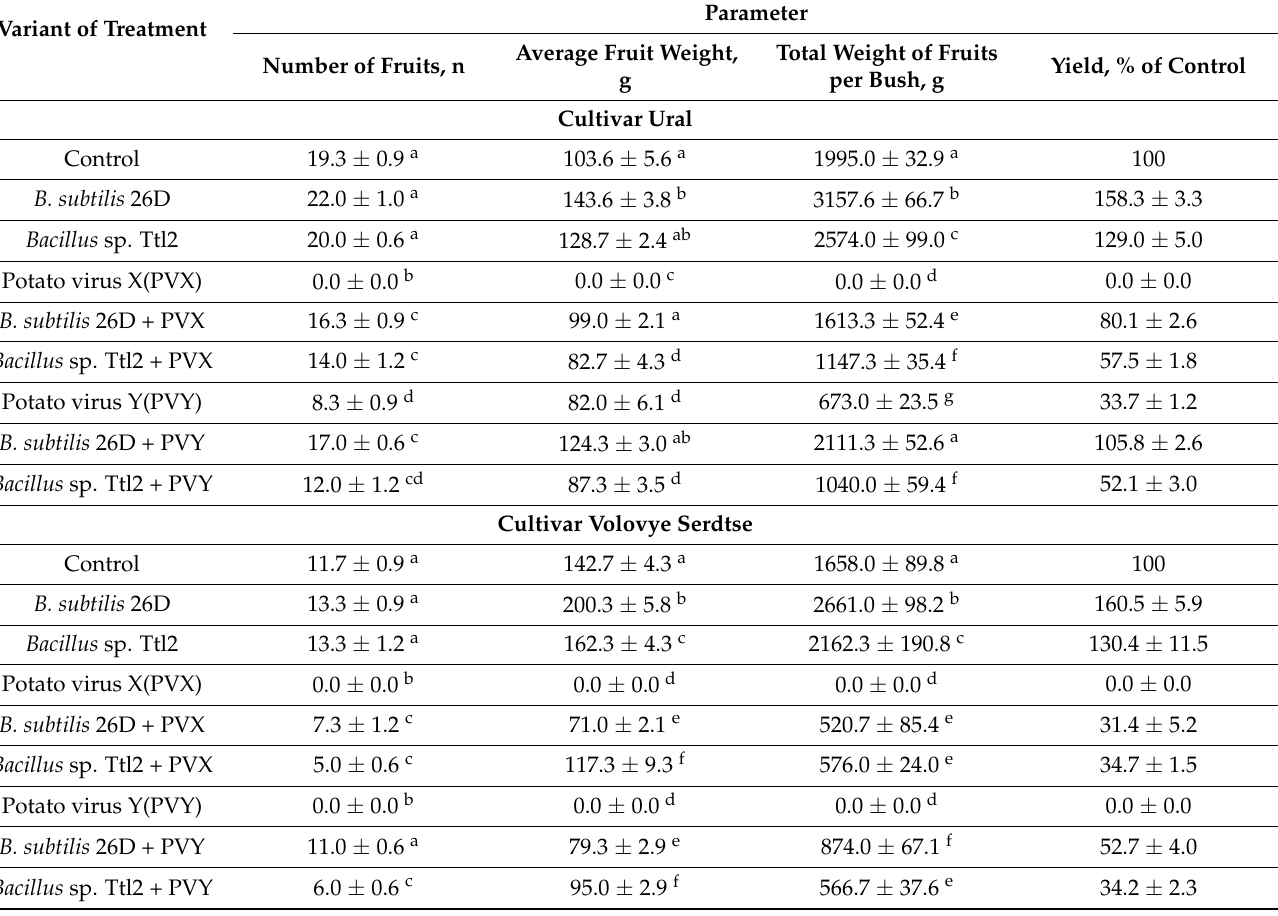
Table 3. Effect of the endophytic strains B. subtilis 26D and B. subtilis Ttl2 on the fruit yield of 2 varieties of tomato plants 14 weeks after infection with PVX and